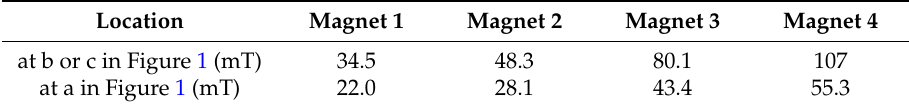
Table 1. Magnetic field strength of Magnets 1–4.